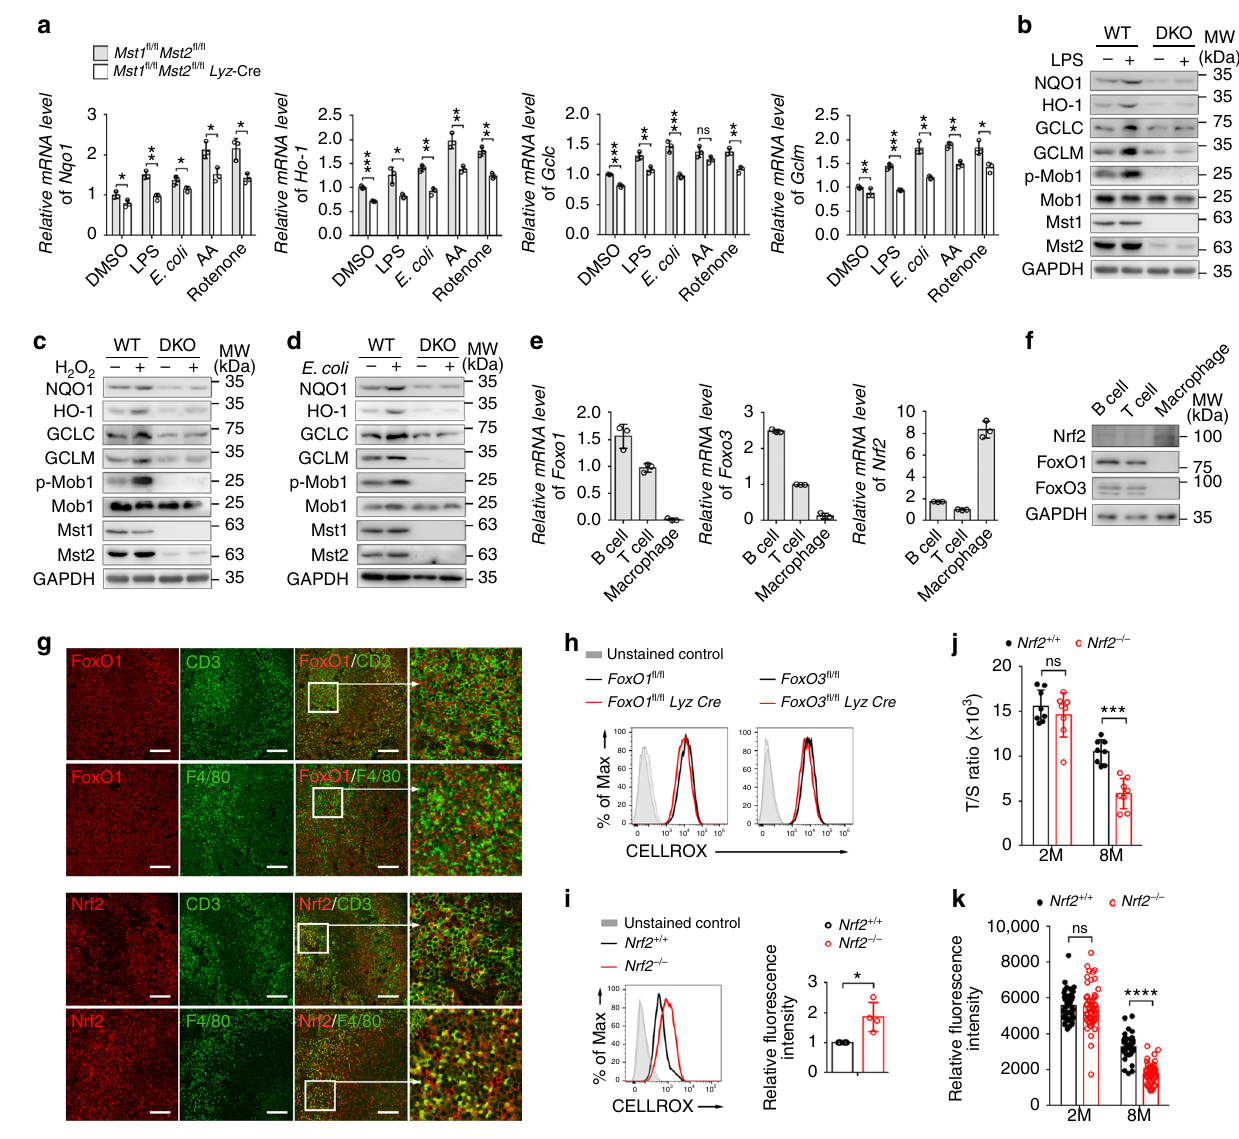
Fig. 4 Dysregulation of Nrf2 in Mst1/2-null macrophages. a RT-qPCR analysis of the mRNA levels of the indicated antioxidant genes in Mst1 fl / fl Mst2 fl / fl (WT) and Mst1 fl / fl Mst2 fl / fl Lyz -Cre (DKO) BMDMs infected with E. coli (MOI: 100) or treated with LPS, antimycin A or rotenone. b – d Immunoblot analysis of GCLC, GCLM, NQO1, HO-1, p-Mob1, Mob1, Mst1, Mst2, and GAPDH in WT and DKO BMDMs treated with LPS ( b ), H 2 O 2 ( c ) or infected with E. coli (MOI: 100) ( d ). e , f RT-qPCR analysis ( e ) and immunoblot analysis ( f ) of the Foxo1 , Foxo3 , and Nrf2 gene expression in WT B cells, T cells and macrophages. g Confocal microscopy of the distribution of FoxO1, Nrf2, CD3, and F4/80 immunostaining in the indicated colors in spleen sections from WT mice. ×16 magni fi cation of areas outlined in the main images are shown next to the main images. Scale bars, 200 μ m. h , i Flow cytometry analysis of ROS levels of FoxO1 − , FoxO3 − ( h ) and Nrf2-de fi cient ( i ) BMDMs and their WT counterparts. The fl uorescence intensity of the ROS dye in the indicated cell samples is shown in the right panel ( i ). j , k The relative telomere length (T/S ratio) ( j ) and relative fl uorescence intensity of telomere FISH ( k ) in peritoneal macrophages isolated from 2- or 8-month-old Nrf2 + / + and Nrf2 − / − mice. ns, not signi fi cant ( P > 0.05), * P < 0.05, ** P < 0.01, *** P < 0.001, **** P < 0.0001 compared with control (Student ’ s t test). Data are from one experiment representative of three independent experiments with similar results (mean and s.d. of n = 3 ( a , e , experimental replicates); n = 4 ( i ) or n = 7 ( j ), biological replicates; mean and s.e.m. of n = 50 ( k ), experimental